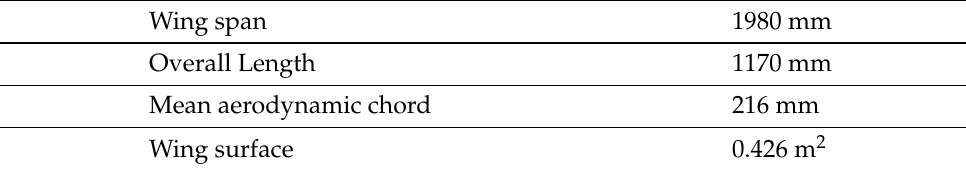
Table 1. Specifications of the UAV.